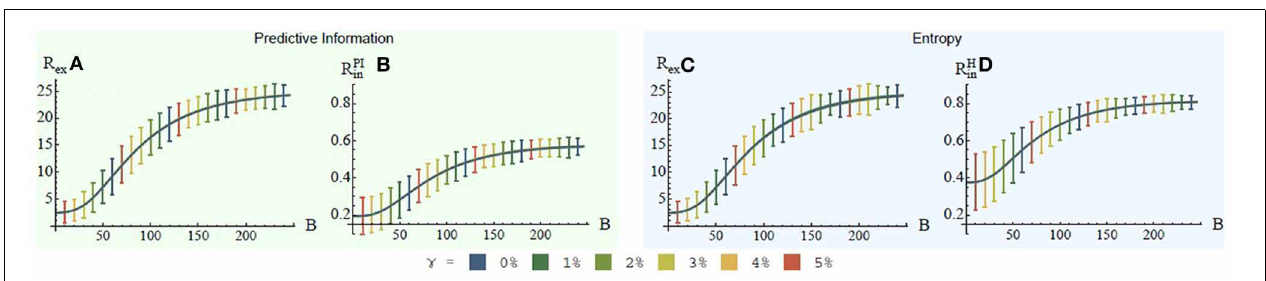
FIGURE 5 | Results for hexapod locomotion task. ERF and IRF with PI maximization (A,B) and entropy maximization (C,D) . No significant effect is observed.